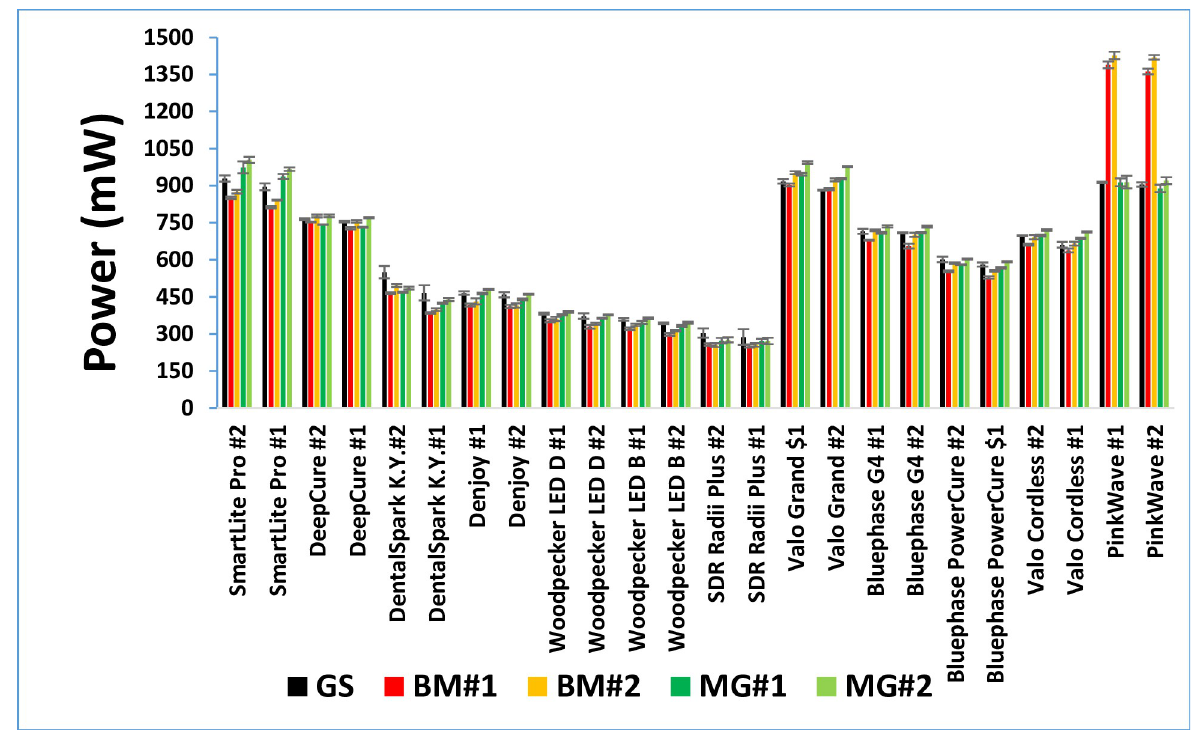
Fig 5. Mean power output(mW) from the LCUs recorded using the gold standard (GS), and the two examples of the Bluephase Meter II (BM#1 and #2) and the Mini Gig (MG#1 and #2) radiometers. Note the range in power values from the LCUs and the overall similarity in the radiometer power values for each LCU, apart from the inability of both Bluephase meters to accurately measure the Pinkwave.